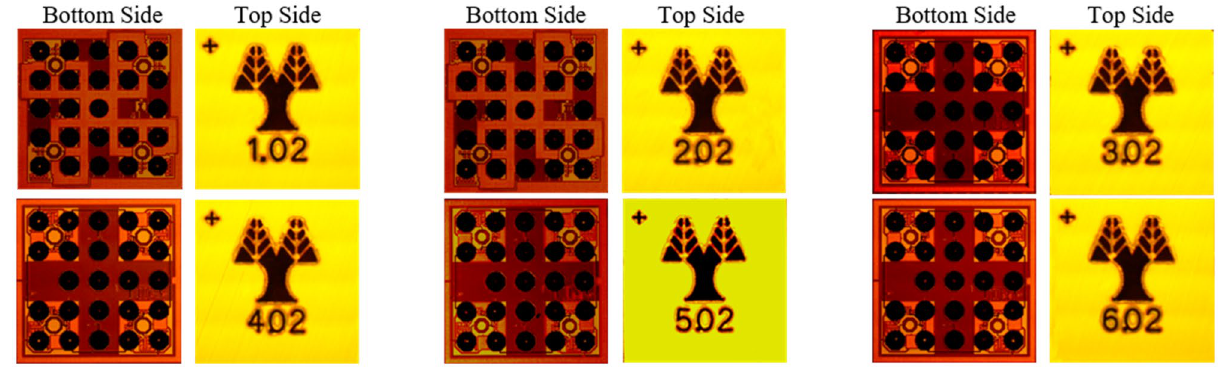
Figure 1. Microphotographs of the ASIC chip family for programmable metasurfaces, showing both top and bottom sides. The ASICs use Wafer Level Chip Scale Package (WLCSP) 35 technology, where the solder-bumps (seen on the bottom side) are directly placed on the I/O pads of a redistribution layer beneath the